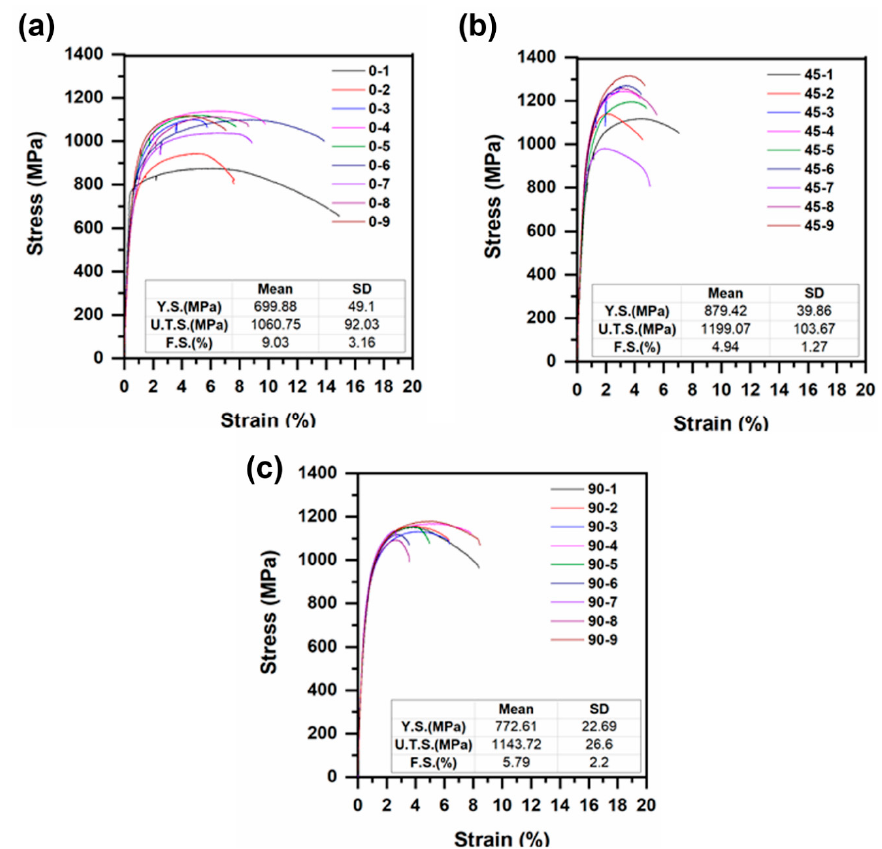
Figure 2. Stress versus strain curves: ( a ) perpendicular; ( b ) 45°; and ( c ) parallel to build direction, in as-printed samples. (Here, Y.S., U.T.S., and F.S. denote yield strength, ultimate tensile strength, and fracture strain, respectively.)